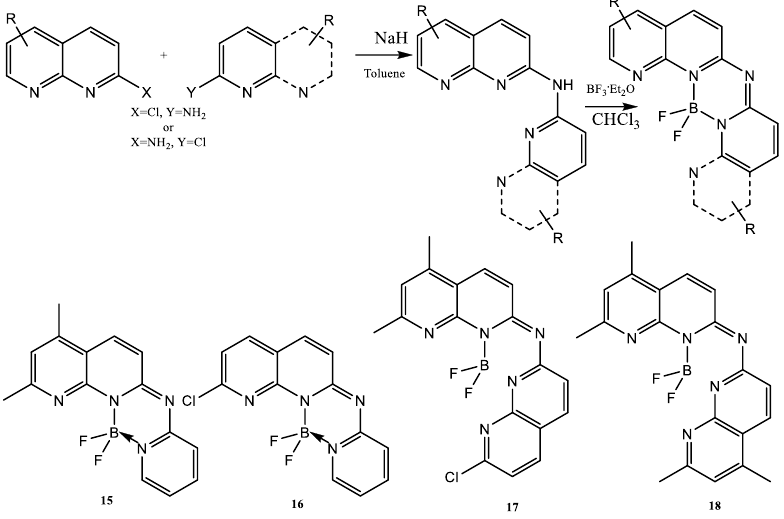
Figure 1. Top: solid-state emissions of complexes 15 – 18 at room temperature. Bottom: photographs of B-form and N-form crystals of 1 under natural light ( a , c ) and under 365 nm UV lamp ( b , d ). Scheme 5. Synthetic routes to and chemical structures of 1, 8-naphthyridine derivatives 15 – 18